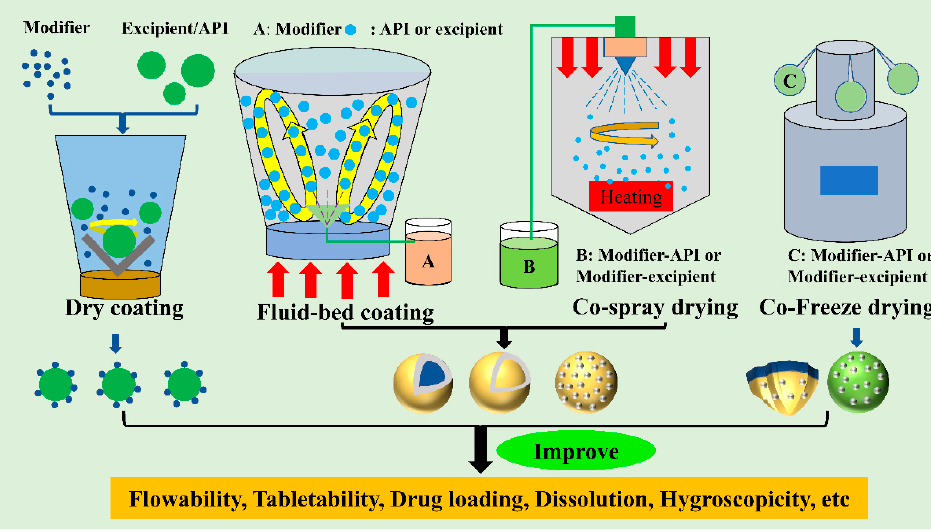
Figure 1. The mechanism of modifiers combined with corresponding co-processing techniques to improve the properties of powders.